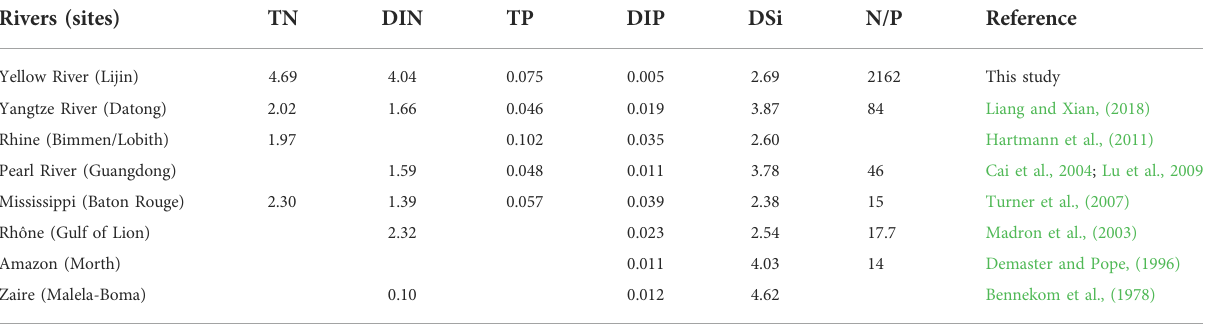
TABLE 3 Nutrient concentrations in some rivers worldwide